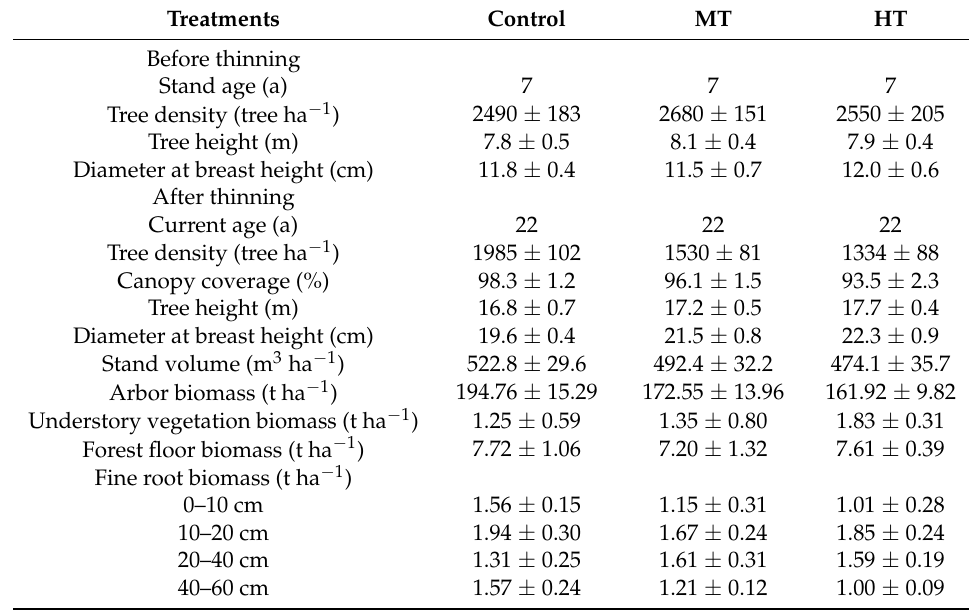
Table 1. Basic characteristics of the three thinning treatments; Control—traditional management model, MT—moderate thinning, and HT—heavy thinning; n = 3–15, mean ±